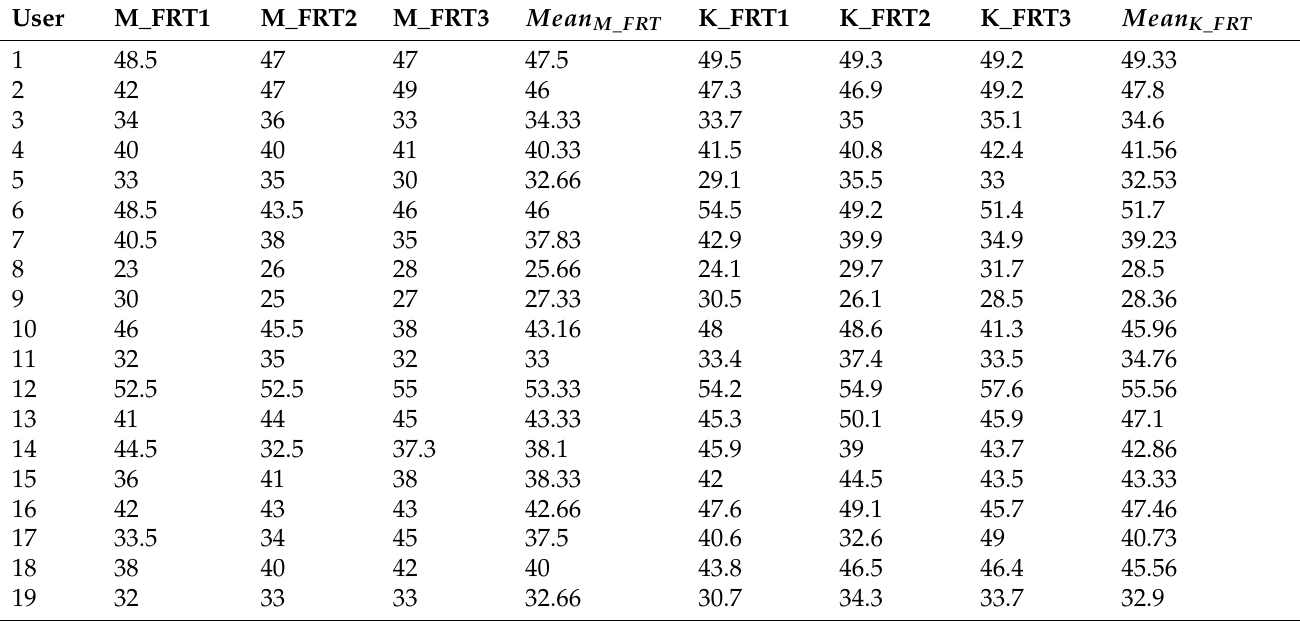
Table A1. FRT measurements obtained during Experiment 1 in